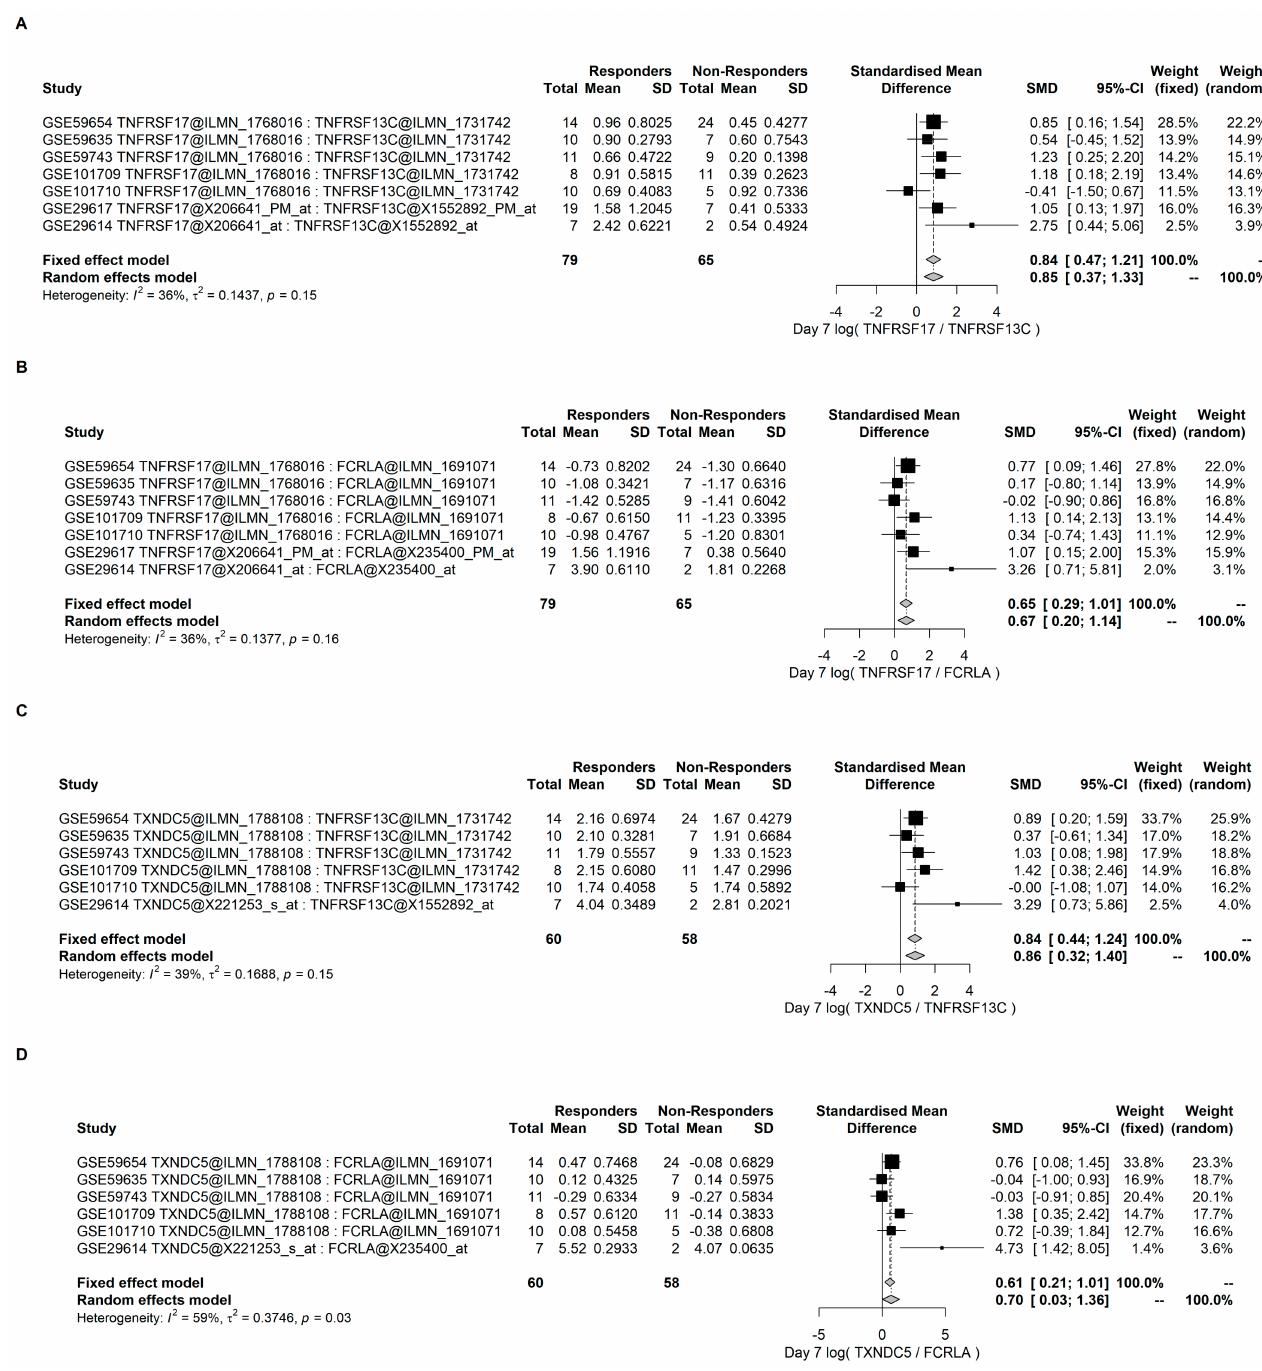
Figure 6. Meta-analysis of the Day 7 results of Direct B lymphocyte-LSTA of TNFRSF17 and TXNDC5 using TNFRSF13C or FCRLA as a reference gene in PBMC datasets. Day 7 Direct B lymphocyte-LSTA was significantly higher among the responder groups with an overall effect SMD of 0.6 to 0.8. The specific probe sets used in the calculation of Direct LS-TA are also shown in the table following the gene symbols. ( A , B ) are the results of Direct LS-TA of TNFRSF17 using two different B lymphocyte reference genes (TNFRSF13C and FCRLA). ( C , D ) show the Direct LS-TA results of TXNDC5.